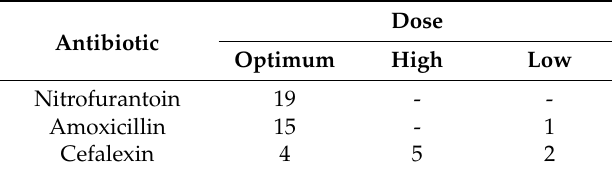
Table 4. Proportion of antibiotic doses according to